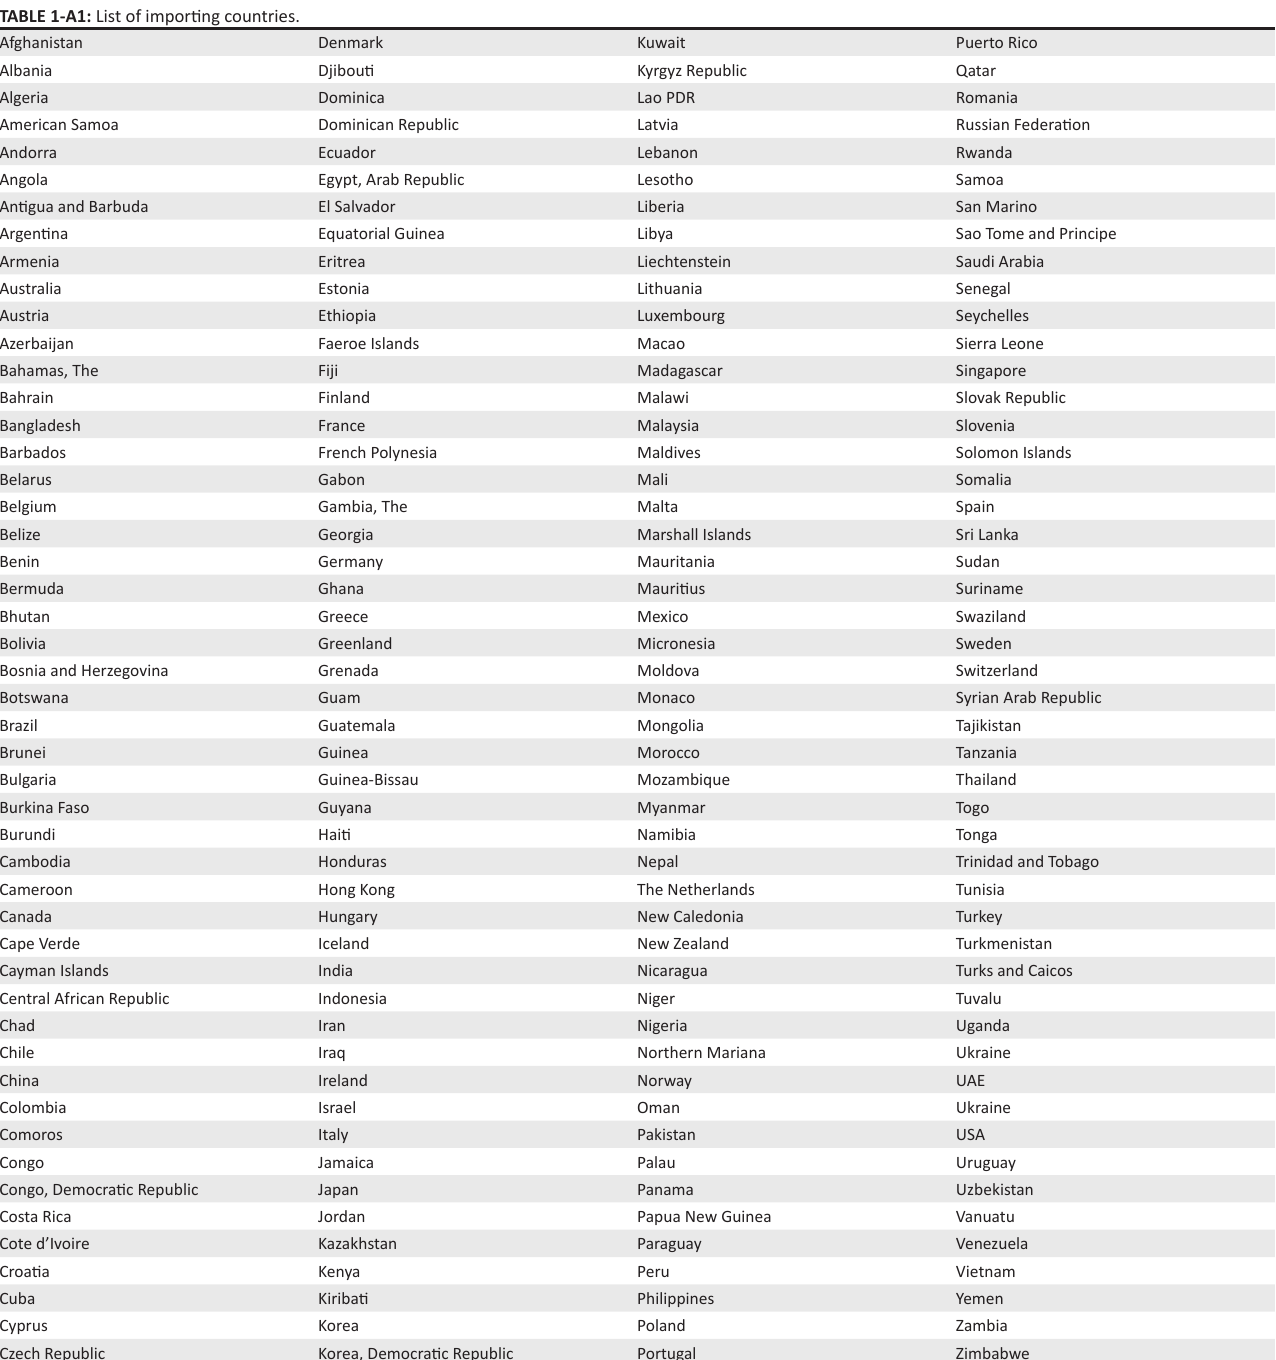
TABLE 1-A1: List of importing